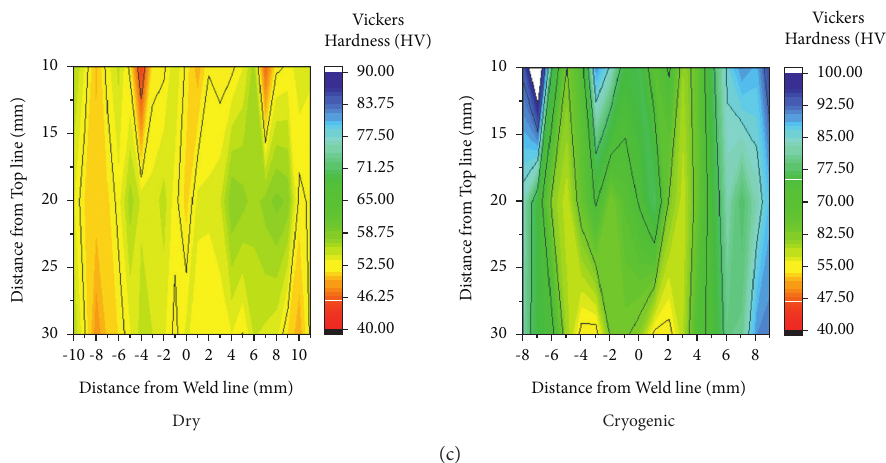
Figure 13: (a) Macroimage showing disparate regions of FSW AA 7075 alloy. (b) Hardness measurement of depicting disparate regions of FSW AA 7075 alloy. (c) Hardness survey for the weld region for FSW AA 7075 alloy.